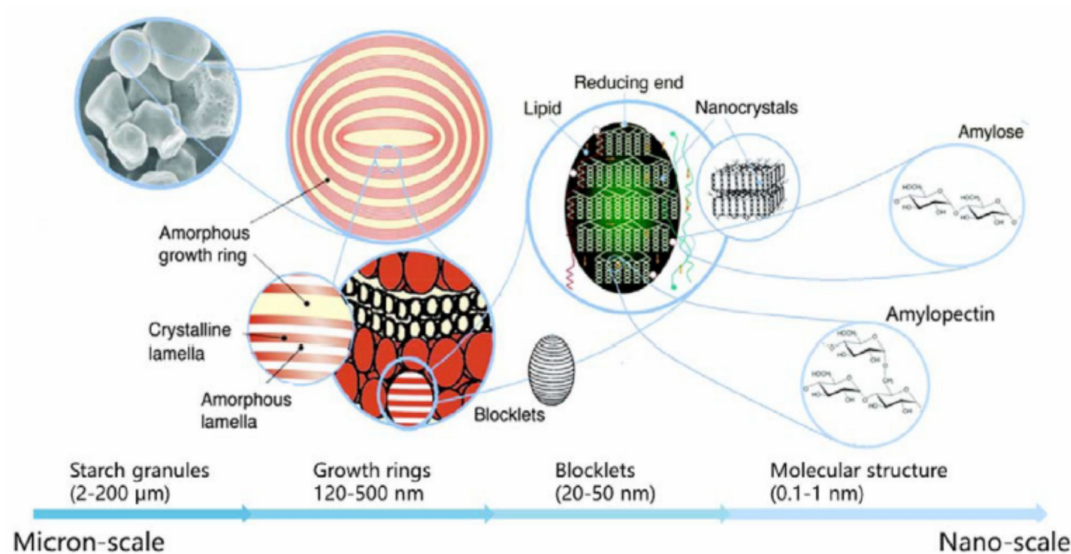
Figure 7. Multi-scale starch structure. Reprinted (adapted) with permission Le Corre, Bras [64] Copyright American Chemical Society and Gallant, Bouchet